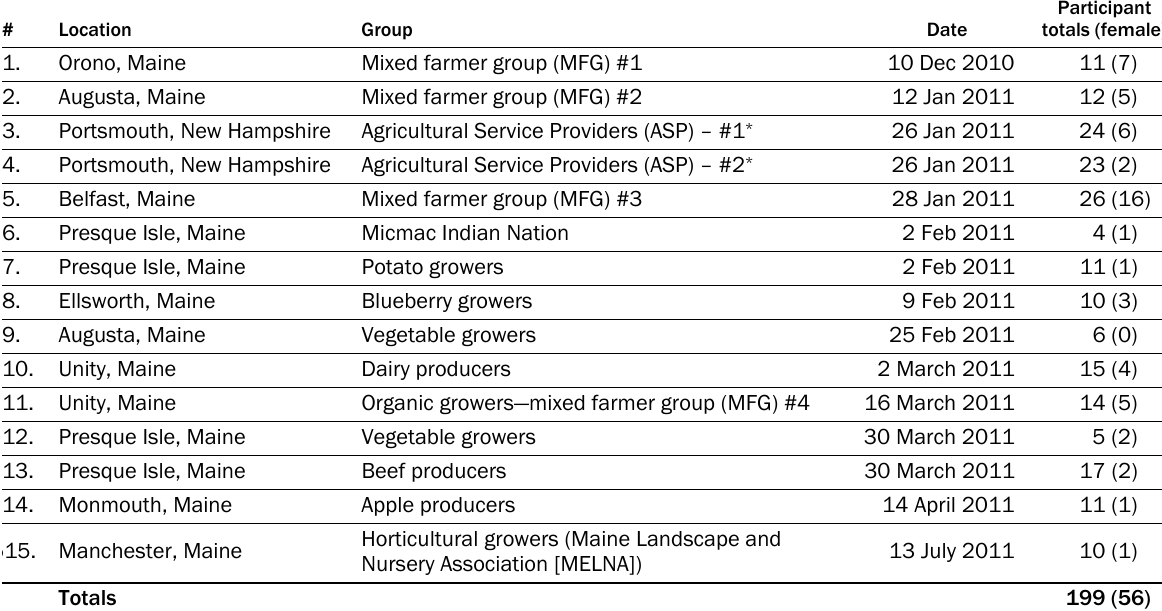
Table 1. Future of Agriculture in Maine — 2025 Focus